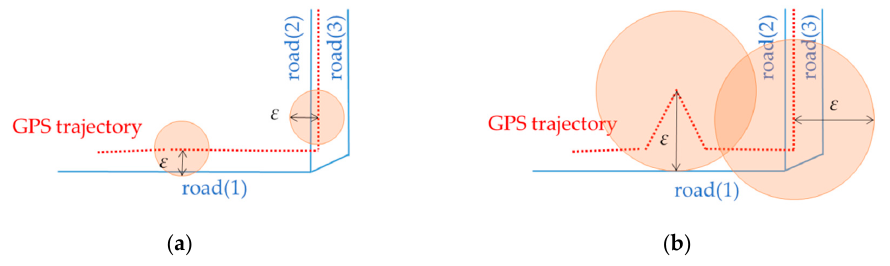
Figure 4. The Fréchet distance approach may be affected by the positional error: ( a ) An ideal case: We can identify the set of matched roads with a small value of threshold ε ; ( b ) a realistic case: The positional error inflates at some parts and ε becomes larger due to